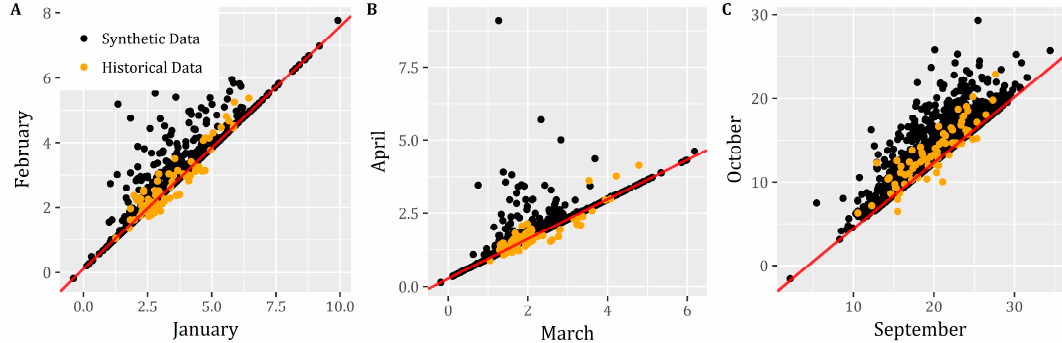
Figure 1. Comparison of the ( A ) January–February, ( B ) March–April, and ( C ) September–October dependence patterns between historical and synthetic monthly runoff data (10 9 m 3 ) of the Nile, at Aswan dam. Synthetic time series were generated by the cyclostationary Thomas-Fiering (TF) approach (adapted by Tsoukalas et al. [33]; the simulated negative values were not truncated to zero in order to avoid distortion of the dependence pattern). The red line (—) depicts the envelope equation of the TF model (when combined with P III white noise. See also Appendix A).